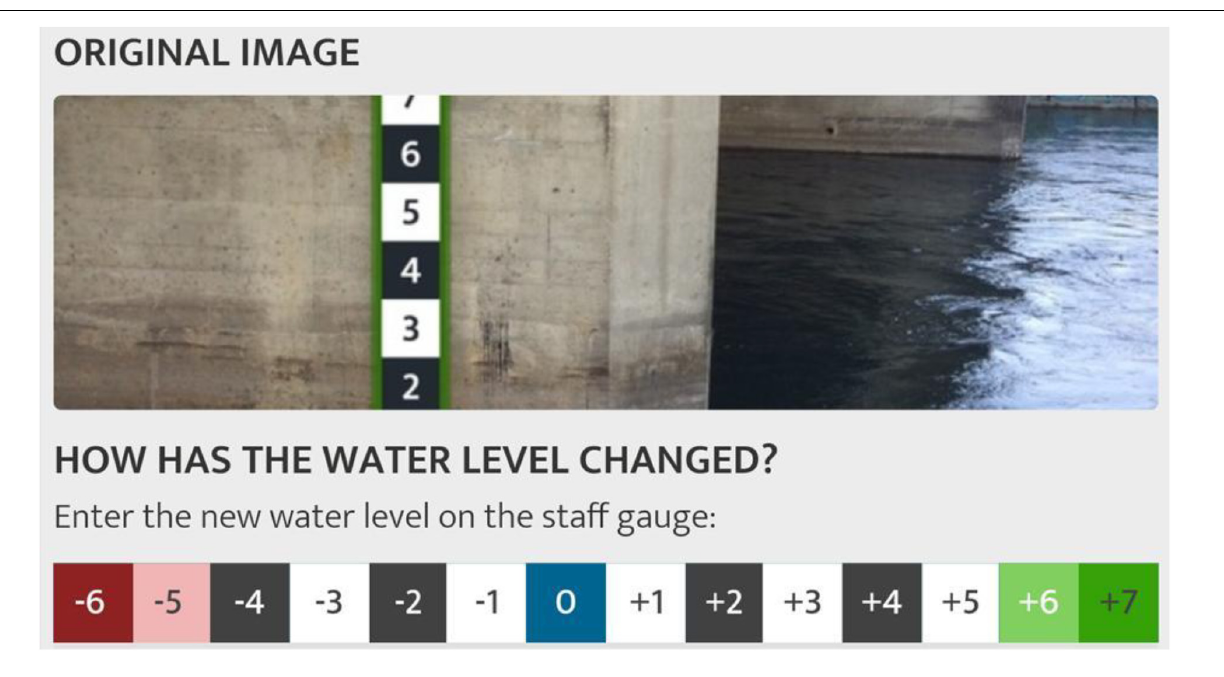
This reference picture with the virtual staff gauge allows anyone who visits the site at a later time to estimate the stream level class by relating the current stream level to the features